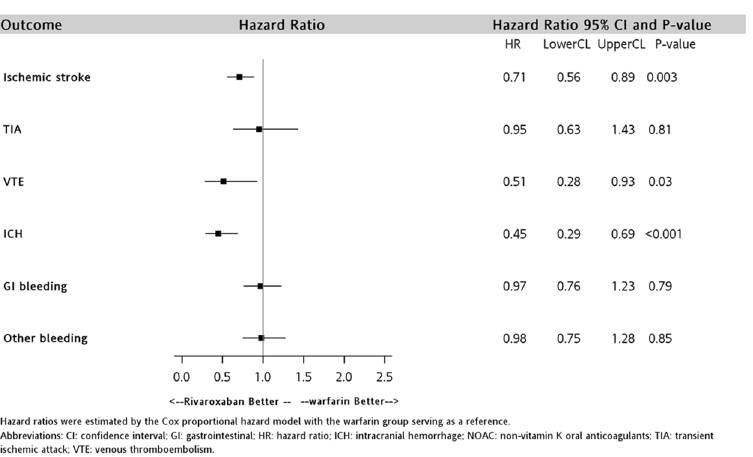
Figure 3. Hazard ratios comparing effectiveness and safety outcomes of rivaroxaban use in patients aged at least 65